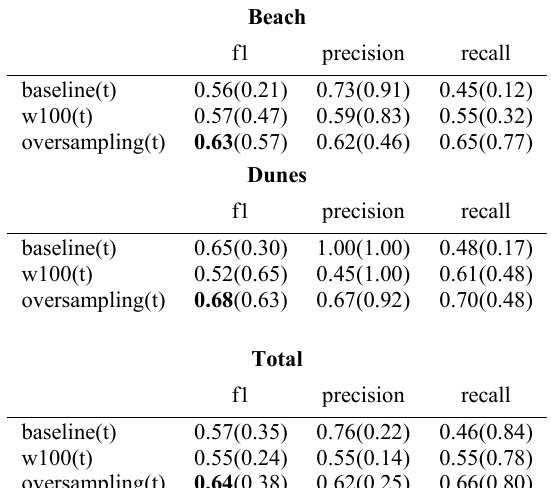
Table 2. Statistical measures of the experiments, f1 score, recall and precision for all the experiments and considering the beach, dunes and all the image data. Between brackets the thresholded version of the experiments (t).